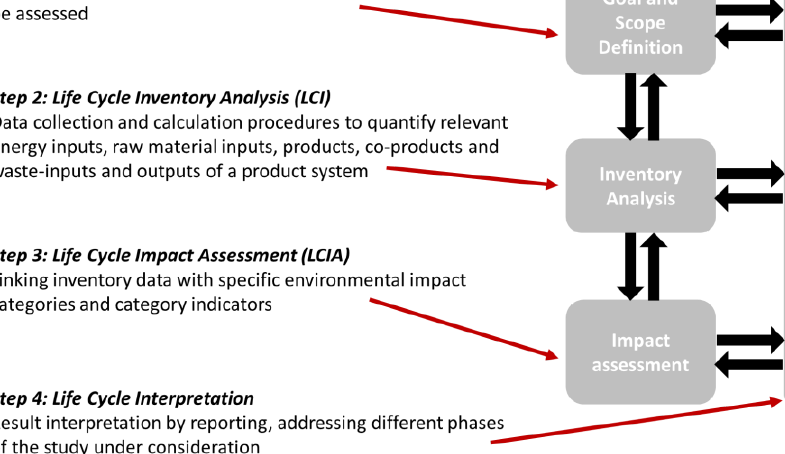
Figure 4. Illustration of the general phases of a life cycle assessment according to ISO 14040:2006.